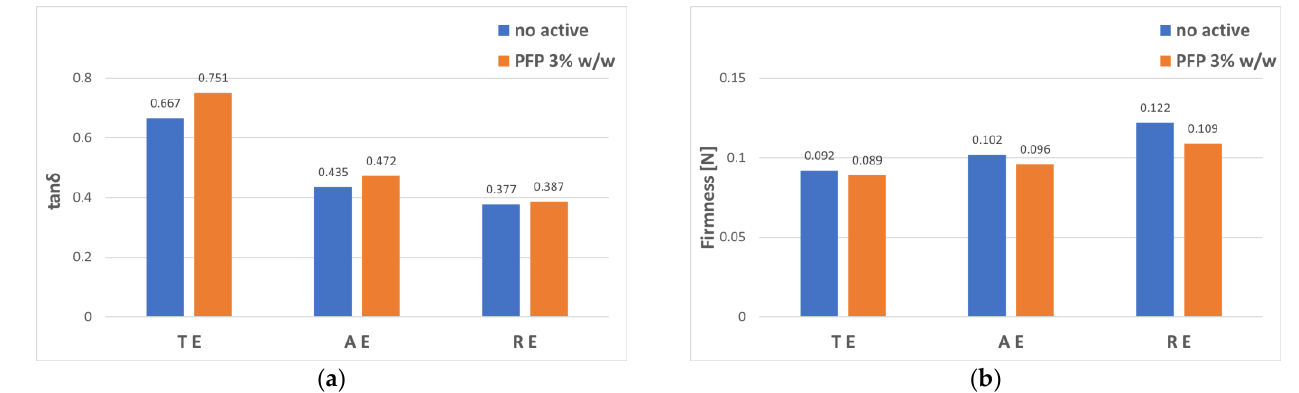
Figure 8. Texture and rheological parameters measured before and after adding 3% w / w of PFP for the gel – creams T E prepared with T at 0.2% w / w and E at 0.5% w / w , A E prepared with A at 0.2% w / w and E at 0.5% w / w , R E prepared with R at 0.2% w / w and E at 0.5% w / w : ( a ) damping factor tanδ at 1.5 Hz obtained from the frequency sweep analysis and ( b ) firmness obtained from the texture analysis.